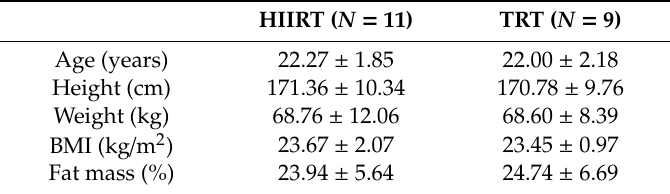
Table 1. Subjects characteristics at baseline.